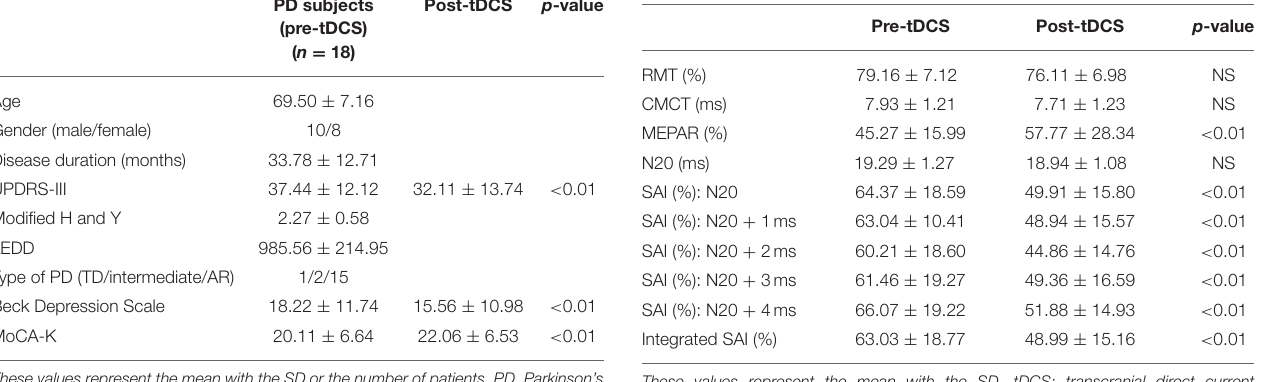
current stimulation. TABLE 3 | Change in electrophysiological parameters obtained by a conventional transcranial magnetic stimulation (TMS) study and SAI evaluation after tDCS.